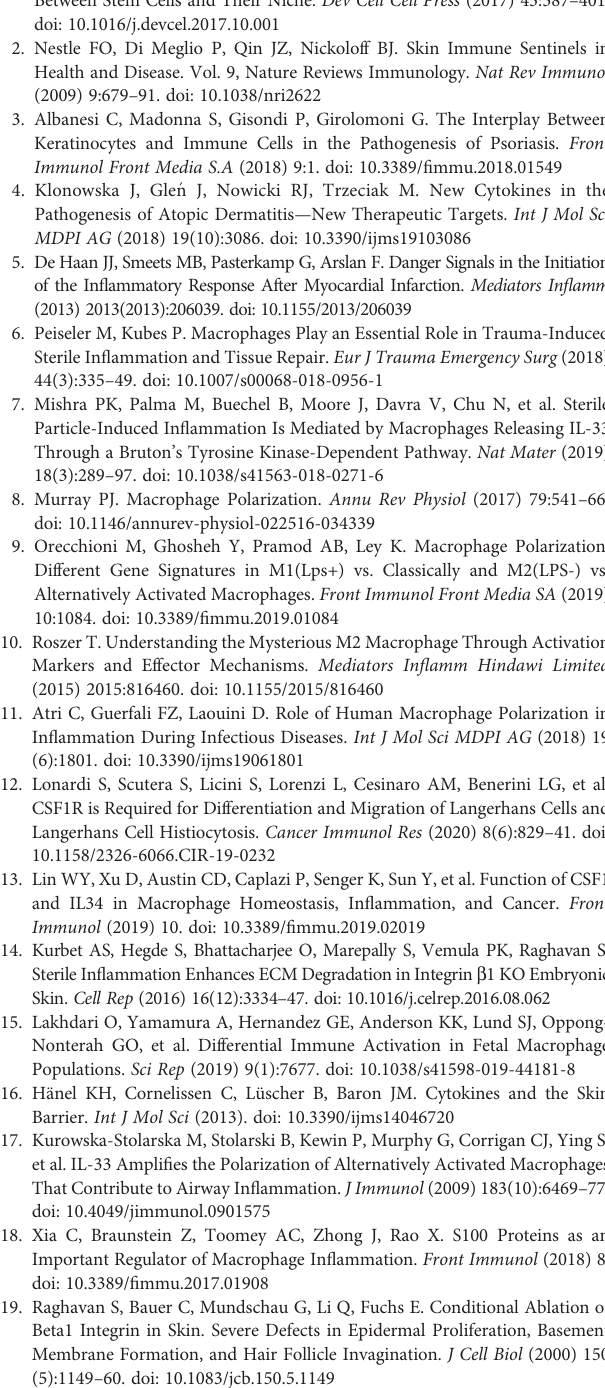
Supplementary Table 3 | List of differentially expressed genes with FDR<0.05 in the epidermis of the CSF1R antibody treated epidermal Itg b 1 KO skin at